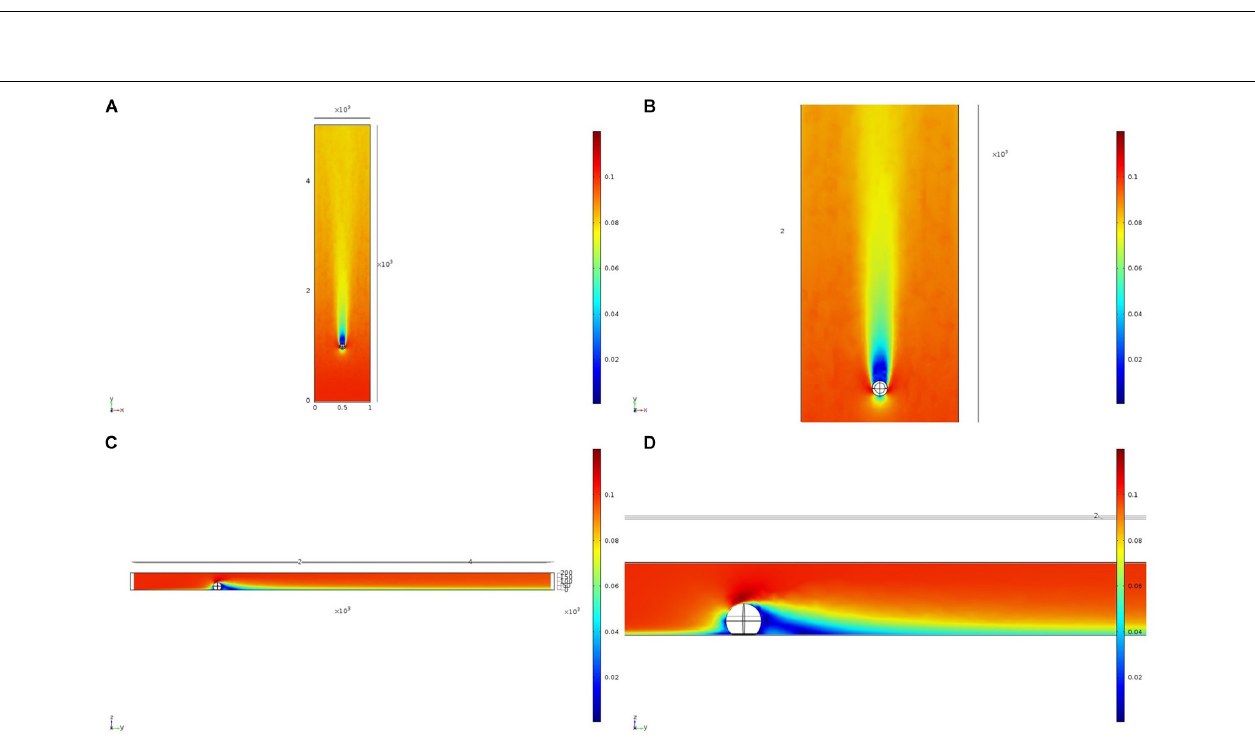
FIGURE 3 | Plots of the Ripley K function clustering analysis (K) for the four study areas (A) HOK study area, (B) Nuuk study area, (C) GOK study area, and (D) SWGL study area. Observed value for K [K obs (r)] theoretical random distribution value for K [K theo (r)] < 95% confidence limit of random distribution between upper confidence bound [K Hi (r)] and lower confidence bound [K lo (r)].